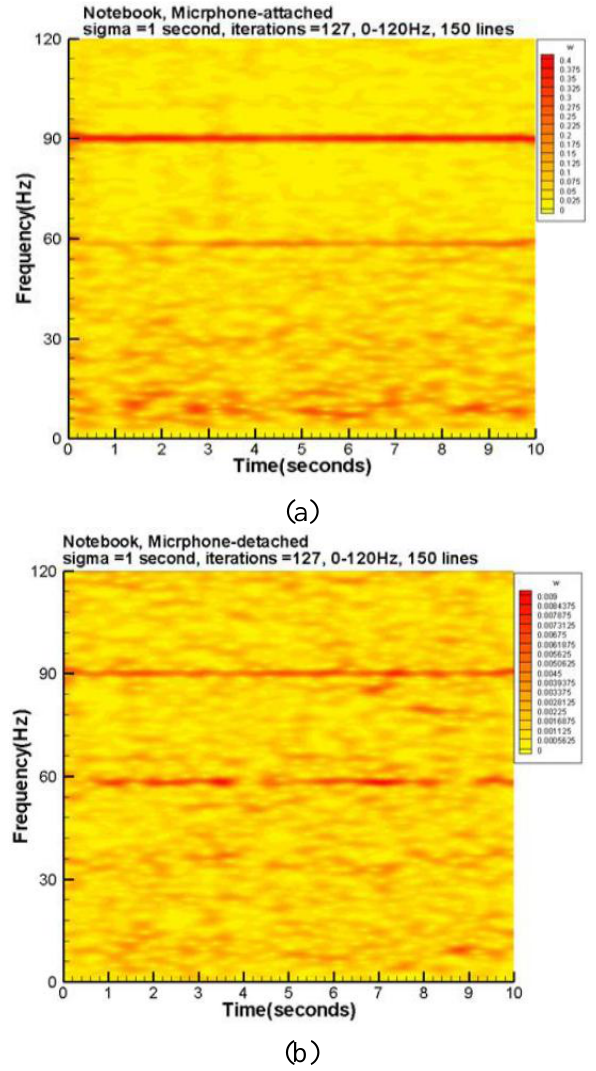
Figure 9. Spectrum registered by notebook computer: (a) microphone attached to the right board of touchpad. (b) microphone at 2 cm above the